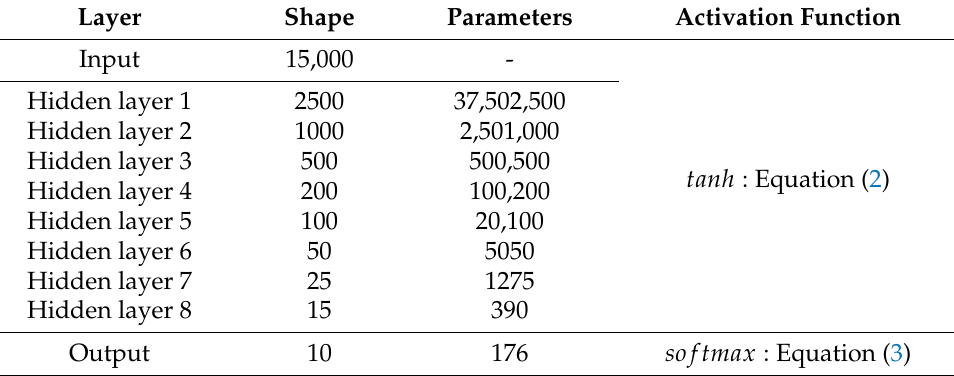
Table 2. Deep learning model for Case Study I. The number of the parameters is equal to the number of connections between the